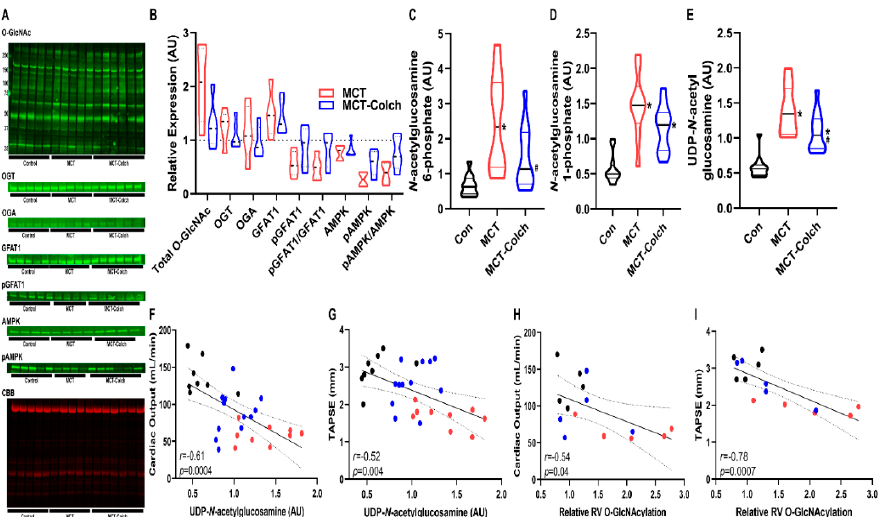
Figure 1. Colchicine activates AMPK, which induces GFAT1 phosphorylation, reduces hexosamine biosynthetic pathway (HBP) intermediate levels, and improves right ventricular function in MCT rats. ( A ) Representative Western blots of right ventricular extracts and quantification ( B ) from control, MCT, and MCT-Colch rats ( n = 4–6 animals per group). O-GlcNAc (MCT: 2.0 ± 0.7 vs. MCT-Colch: 1.3 ± 0.4 fold increase compared to control), OGT (MCT: 1.2 ± 0.3 vs. MCT-Colch: 1.1 ± 0.3 fold increase compared to control), OGA (MCT: 1.2 ± 0.5 vs. MCT-Colch: 1.0 ± 0.3 fold increase compared to control), GFAT1 (MCT: 1.5 ± 0.4 vs. MCT-Colch: 1.4 ± 0.3 fold increase compared to control), phosphoGFAT1 (MCT: